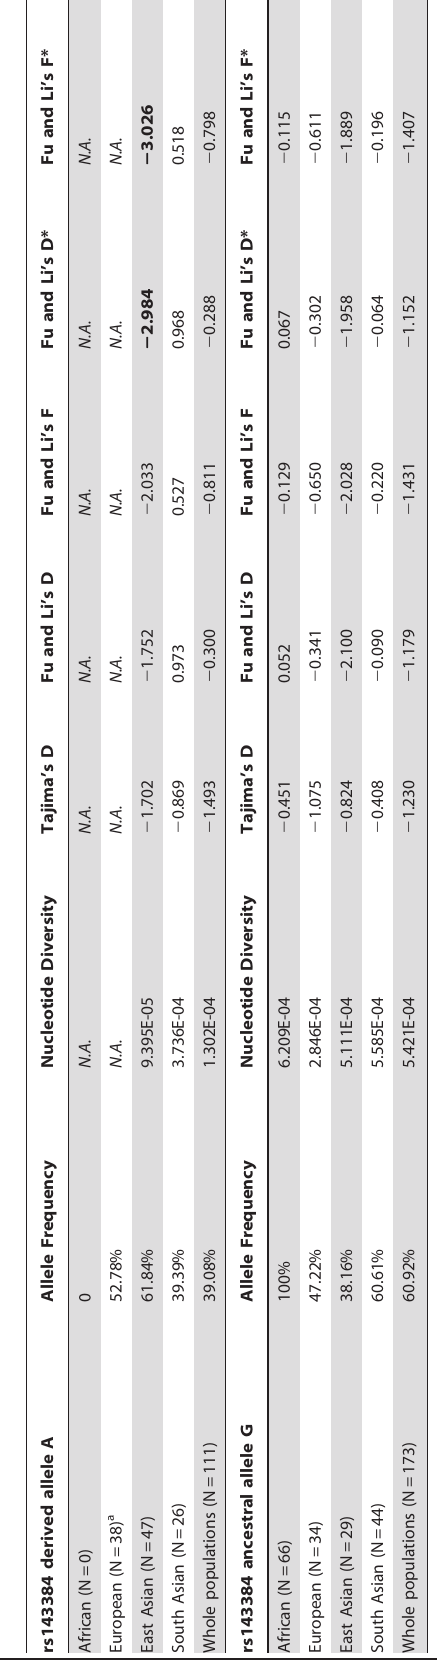
t =g*25 = 499.2*25= 12,480 years, and the age of derived allele of